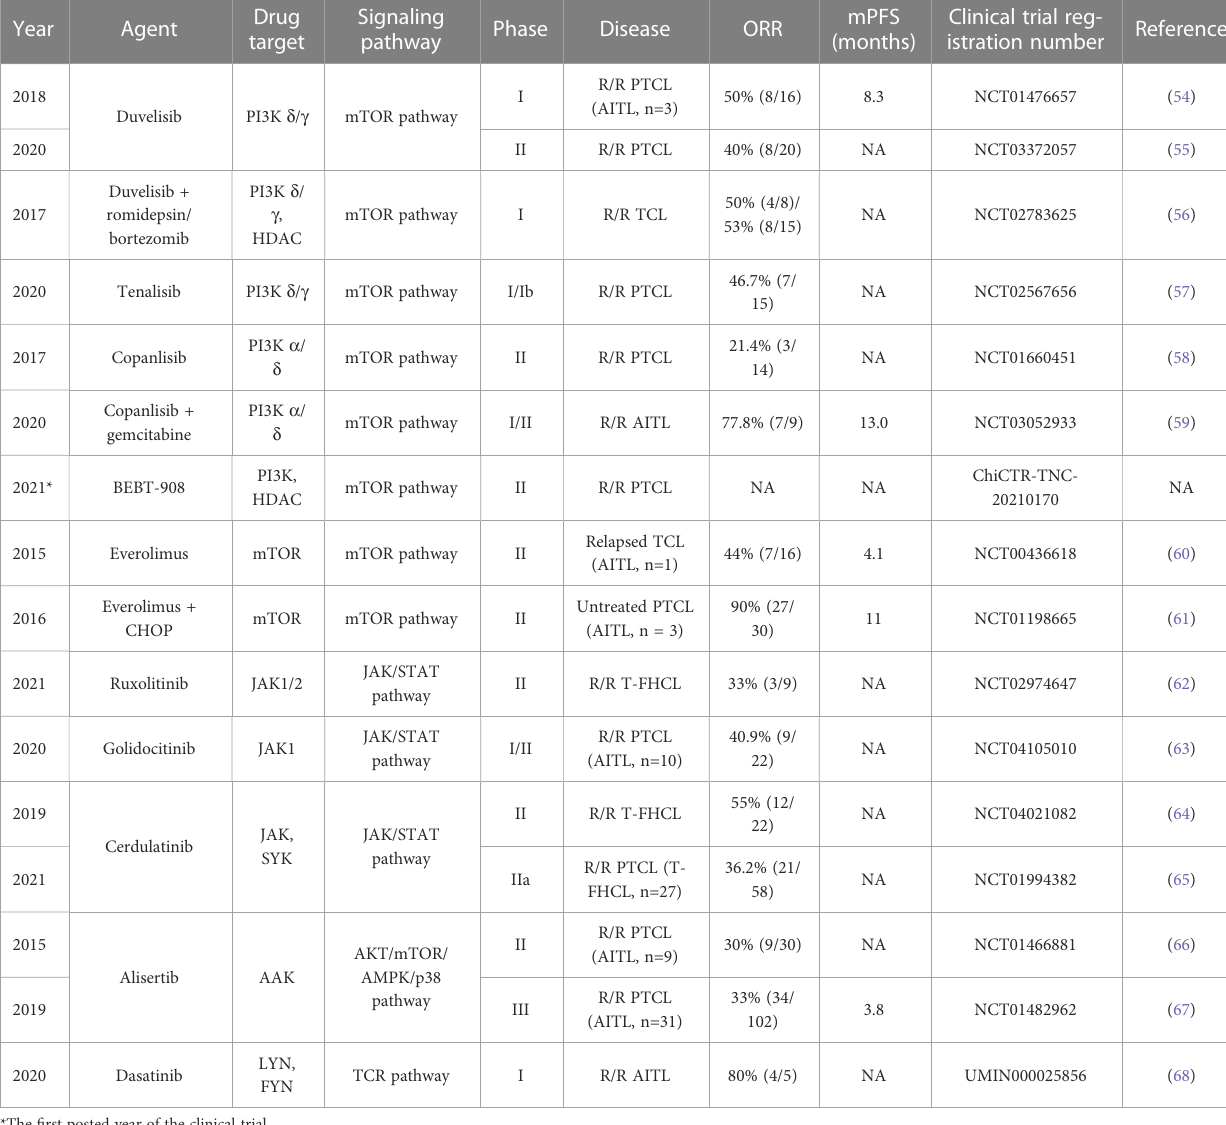
TABLE 3 Novel and experimental agents targeting kinases in